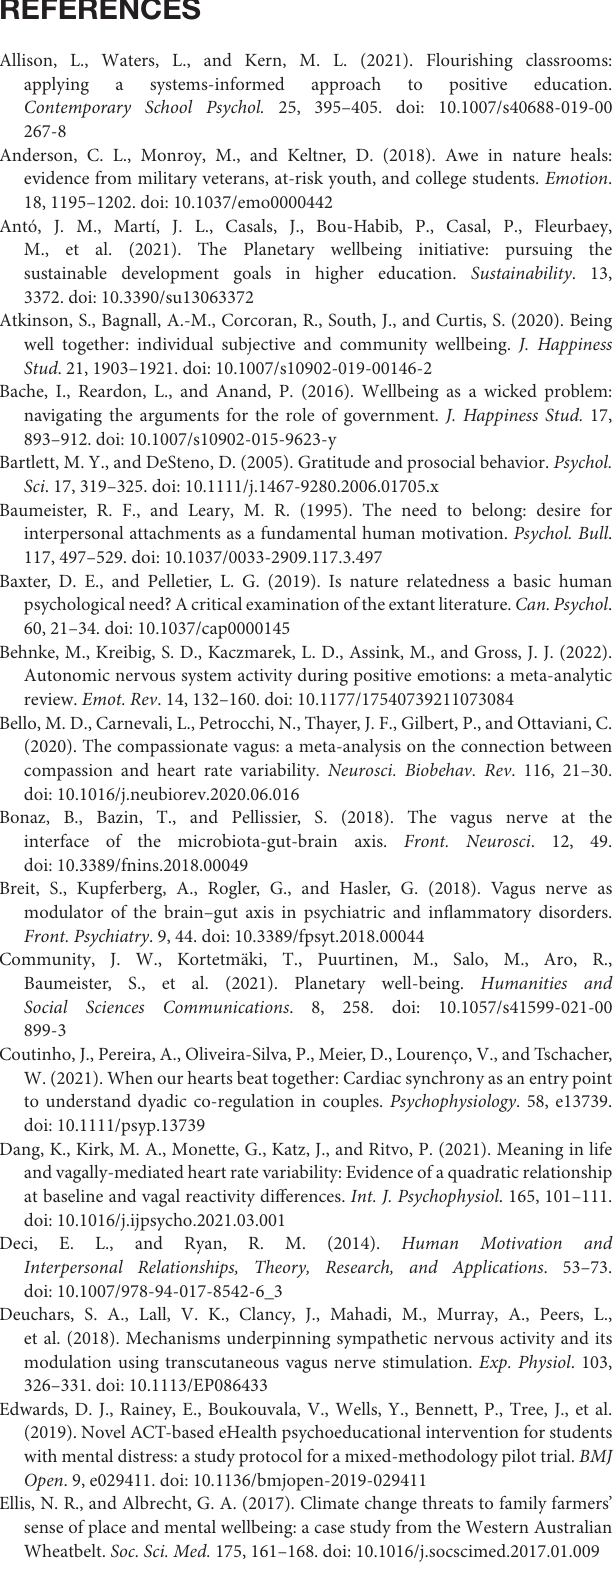
Frontiers in Integrative Neuroscience |